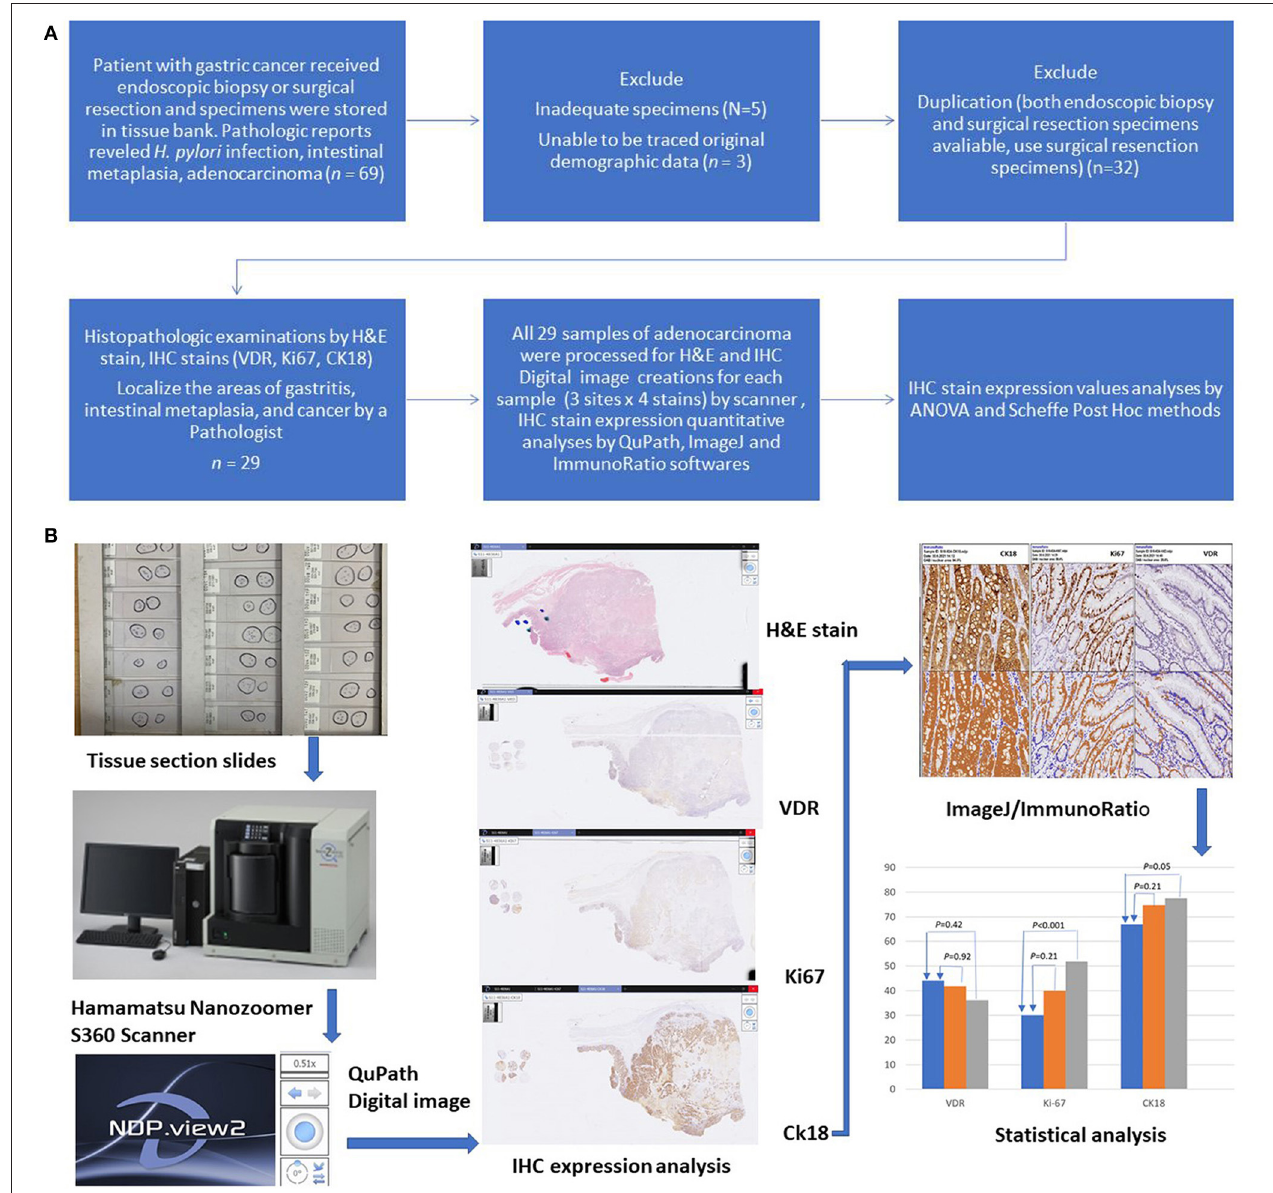
FIGURE 1 | (A) Study flow diagram. All 29 samples of adenocarcinoma were processed for H&E and IHC stain. (B) Graphic flow chart.